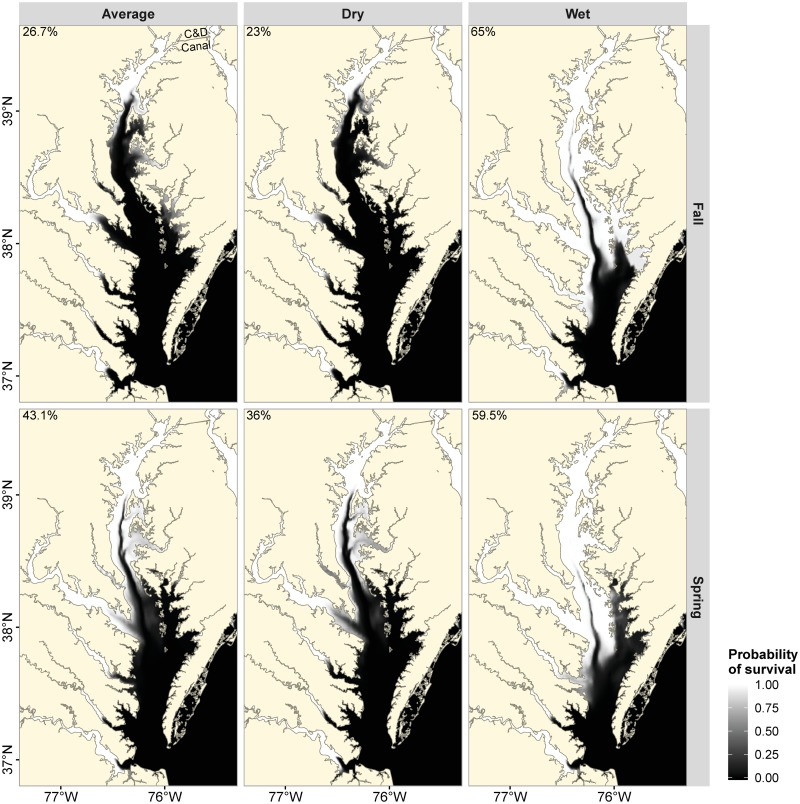
Spatially explicit probabilities of survival (72-hour) for a 224 mm blue catfish (median length in the salinity tolerance experiment) throughout the Chesapeake Bay based on vertically-averaged salinities in spring (April) and fall (October) during average (2012), dry (2009) and wet (2011) years.Number at the top left corner of each panel denotes the percent area of the Chesapeake Bay where predicted probability of survival for blue catfish was greater than 0.8. Note that the probability of survival was nearly 1 in the Chesapeake and Delaware Canal (C&D Canal).